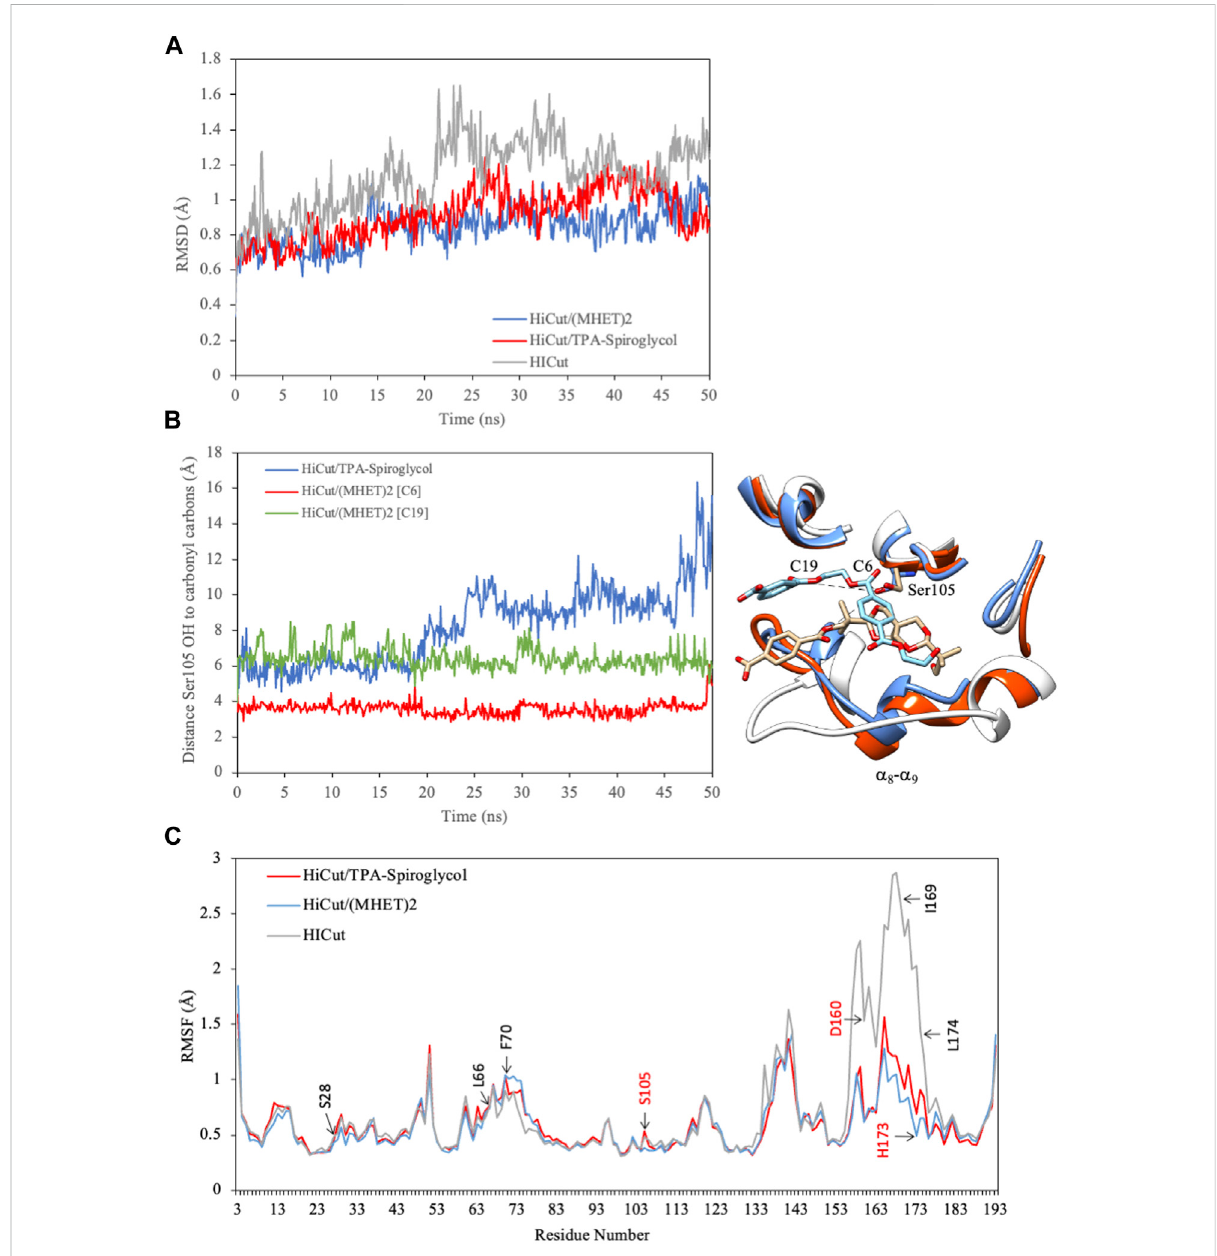
FIGURE 9 MoleculardynamicssimulationoffreeHiCutandincomplexeswithligands. (A) RMSDofalfacarbons.Ingreyfreeenzyme,with(MHET) 2 inblue and with TPA-spiroglycol ester in red. (B) Distances fl uctuation between the oxygen of the Ser105 (nucleophile) to the carbonyl carbons of the ester bonds in TPA-spiroglycol (blue) and (MHET) 2 (green for C19 and red for C6). In the right the conformational changes in the active site loop ( α 8- α 9) and ligands. (MHET) 2 is with carbon atoms in blue and oxygens in red, while TPA-spiroglycol is with carbon atoms in brown and oxygens in red. (C) RMSF of alfa carbons labeling the amino acids surrounding the active